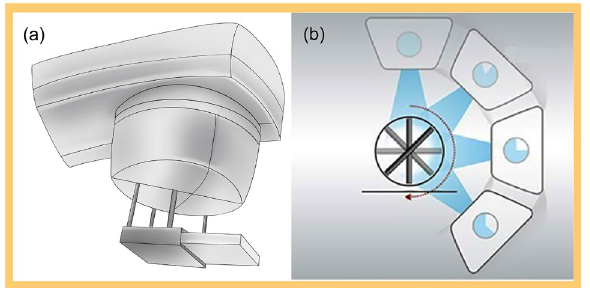
Figure 2. Schematic diagram of Compass devices. ( a ) The MatriXX detector array is mounted on the linac head inside a frame. ( b ) Treatment planning is delivered with the centre of MatriXX at the isocenter in the holder, keeping the array normal to the beam axis during delivery.